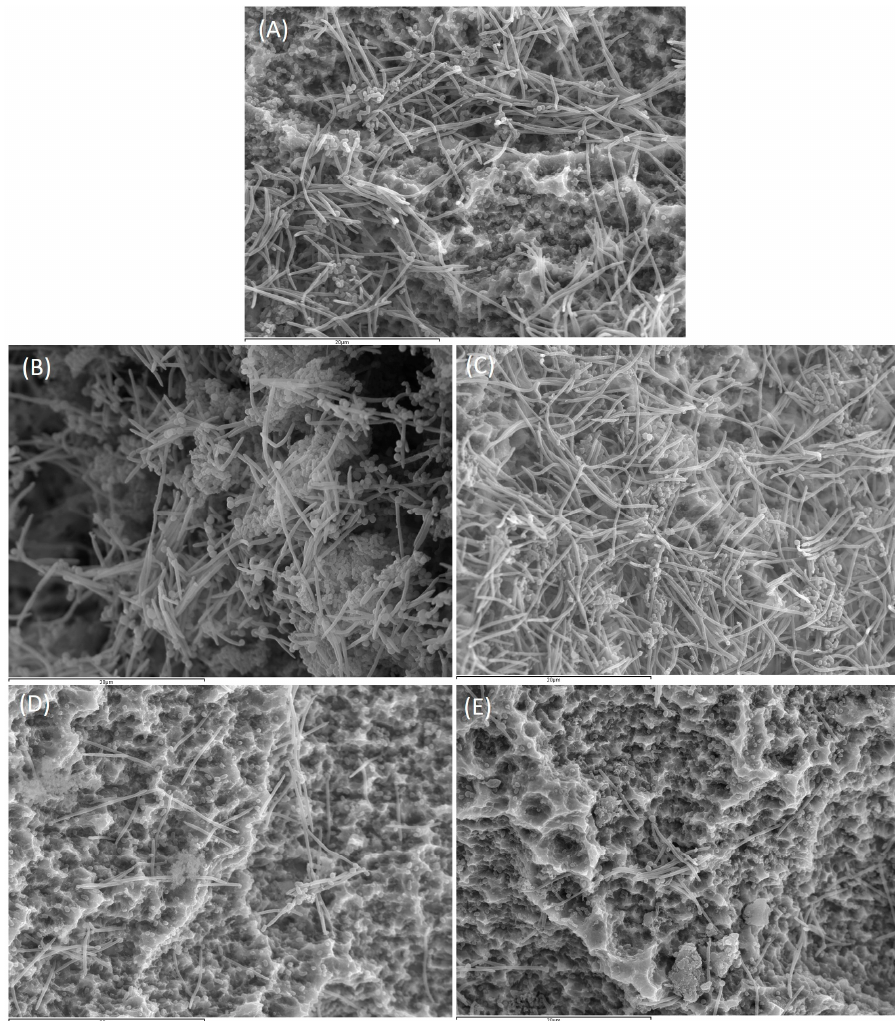
Figure 4. Images obtained by scanning electron microscope (SEM) with 2500 × magnification of biofilm developed at 72 h over implants treated with phosphate buffer saline (PBS) ( A ), 0.2% chlorhex- idine (CHX) ( B ), 2.5% dimethyl sulfoxide (DMSO) ( C ), 100 µ M xanthohumol ( D ) and 5 mM curcumin ( E ) (scale bar = 20 µ